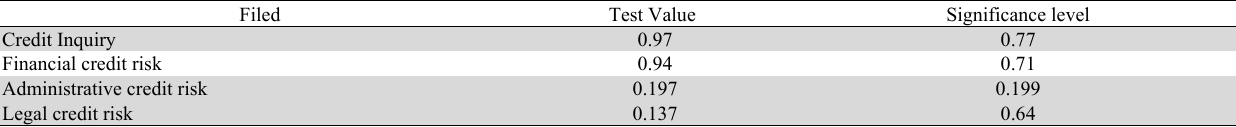
Natural Distribution by Applying Kolmogorov-Smirnov (K-S) Test Filed